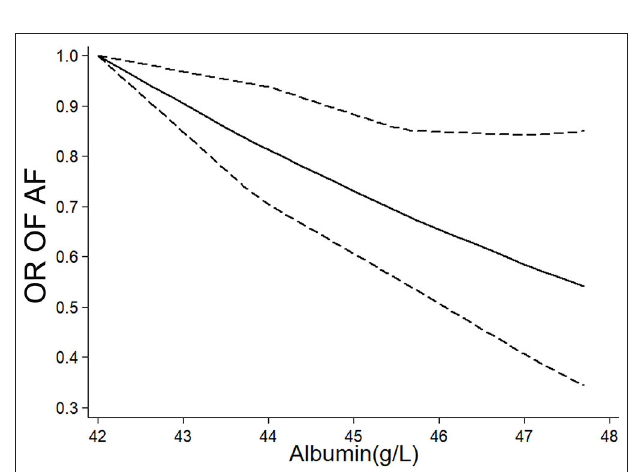
FIGURE 3 | Nonlinear exposure–effect analysis between serum albumin level and risk of atrial fibrillation, the solid and dashed lines represent the estimated odd risk and the 95% confidence interval, respectively. AF, atrial fibrillation; OR, odd